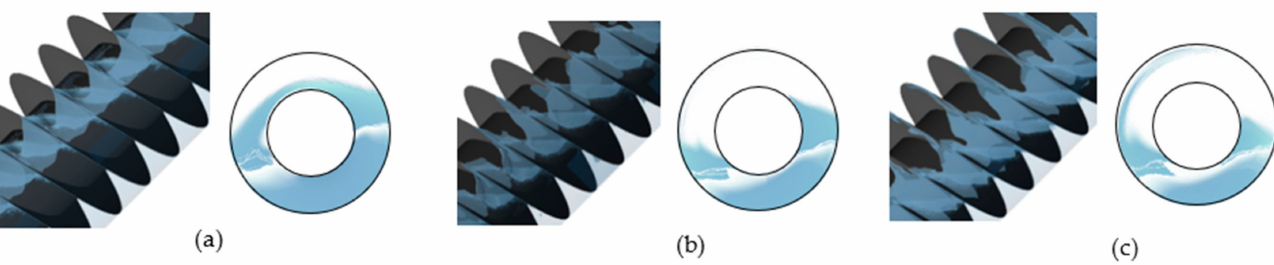
Figure 12. Screw filling for different rotational speed ( a ) overfilling at low rpm ( b ) optimal filling at operating rpm ( c ) under filling at high